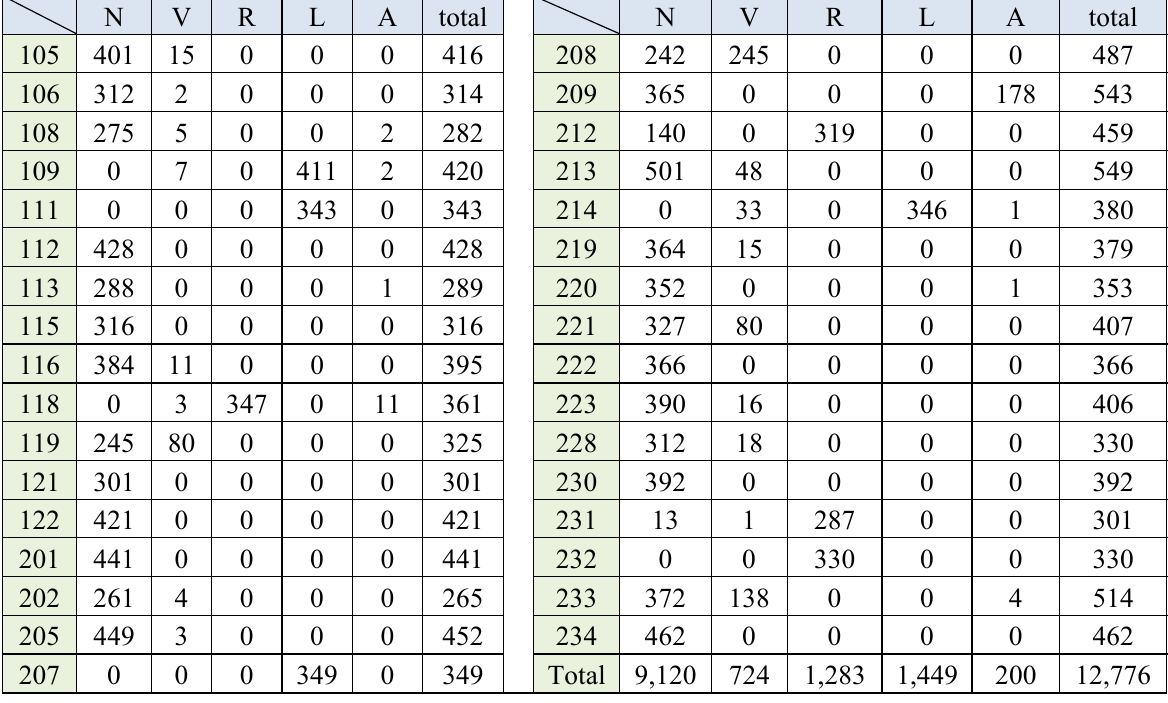
Table 1. The selected 33 files and the number of each arrhythmia